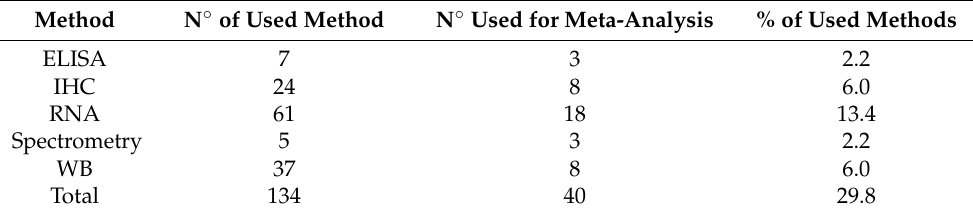
Table 6. Methods of iNOS detection and number of methods valuable for